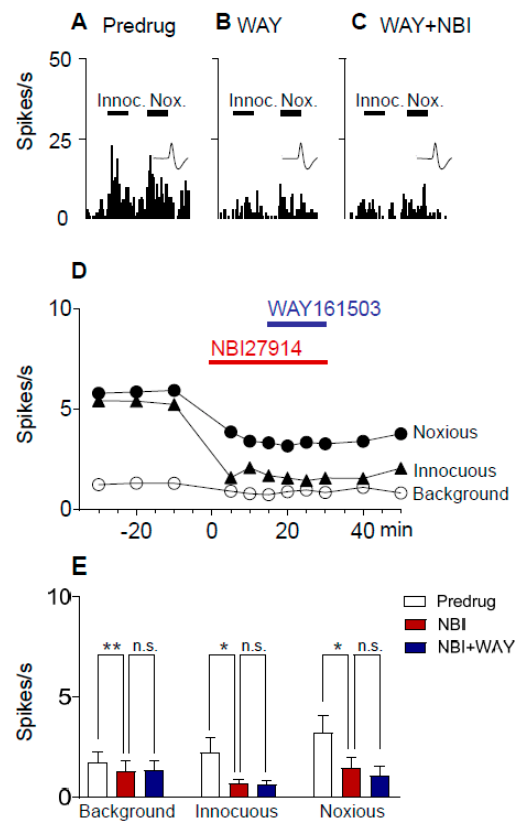
Figure 6E. The inhibitory effects of NBI27914 on background activity and responses to innocuous stimuli were significant, and the inhibitory effects persisted during co-administration of WAY161503, suggesting that the CRF1 receptor antagonist prevented the effects of the 5-HT 2C R agonist ( n = 6 neurons; background activity, p < 0.01, F (2,10) = 14.54; innocuous, p < 0.05, F (2,10) = 6.073; noxious, p < 0.01, F (2,10) = 10.31; ANOVA).